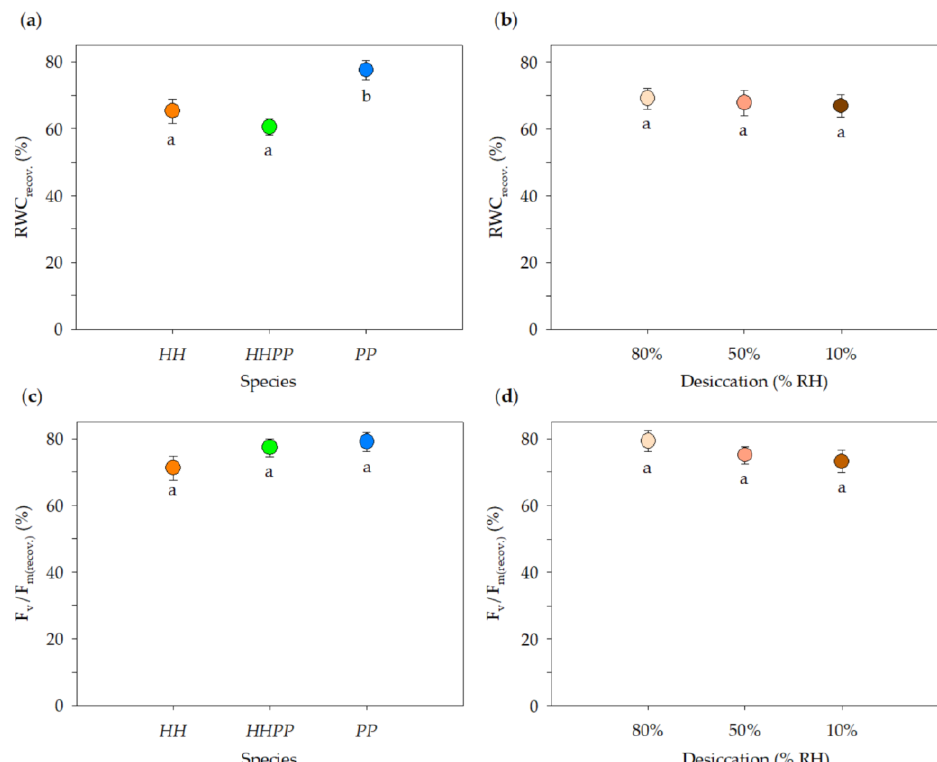
Figure 3. Mean values (± SE) of RWC recov. and F v /F m(recov.) for the three Oesporangium species after three desiccation levels (80%, 50%, and 10% relative humidities) followed by rehydration (recovery): ( a ) RWC recov. , comparison of species; ( b ) RWC recov. , comparison of desiccation levels; ( c ) F v /F m(recov.) , comparison of species; ( d ) F v /F m(recov.) , comparison of desiccation levels. Different letters indicate significantly different means ( p < 0.05, Tukey tests). n = 17 individuals per species. See Table 2 for ANOVA results.